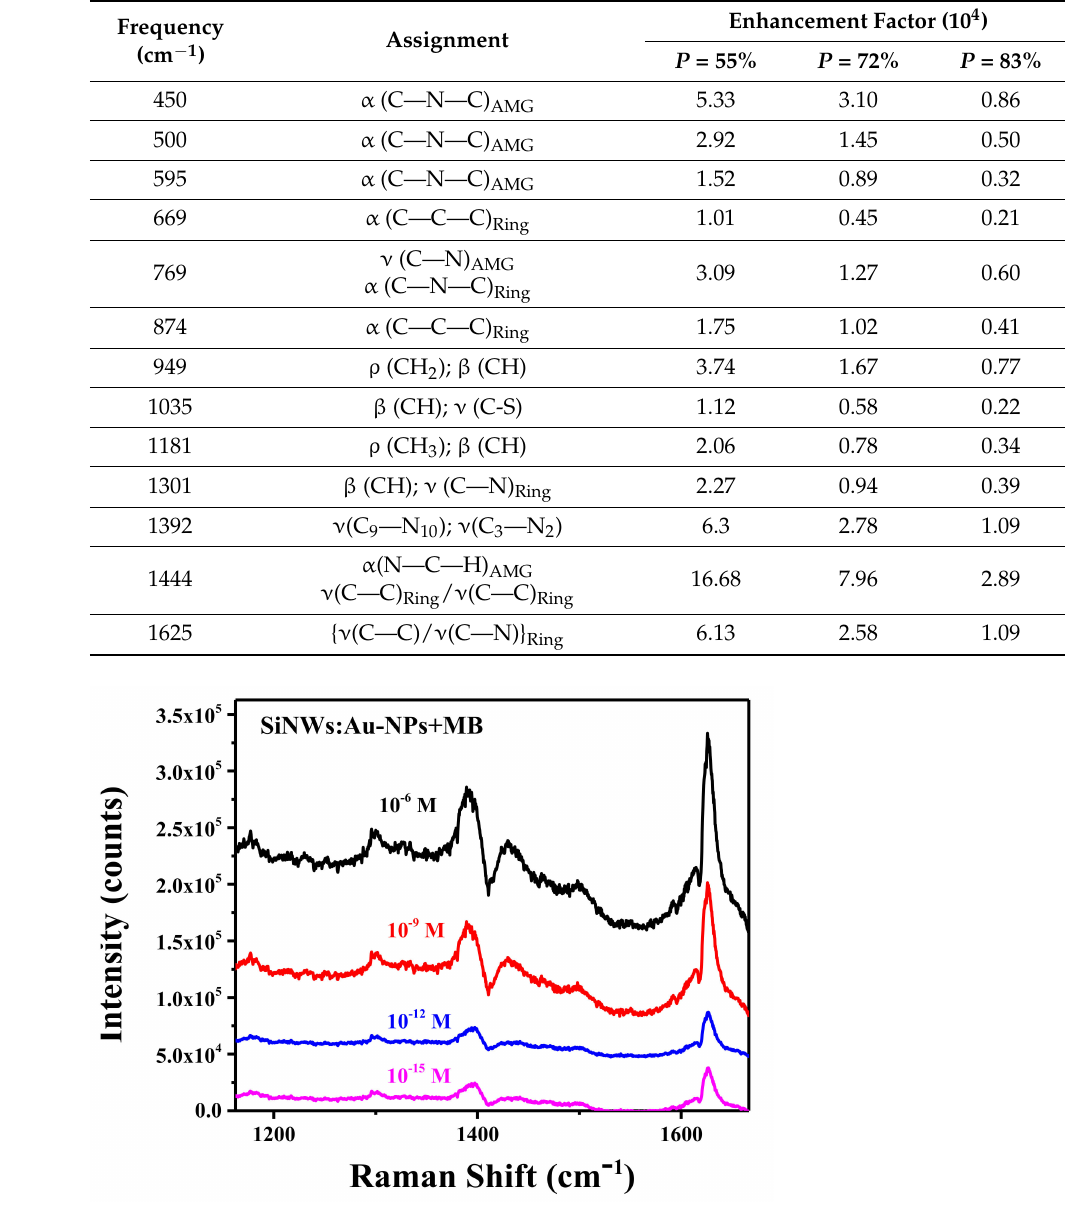
Figure 8. SERS spectra of SiNWs:Au-NPs ( P = 55%) with different concentrations of deposited MB